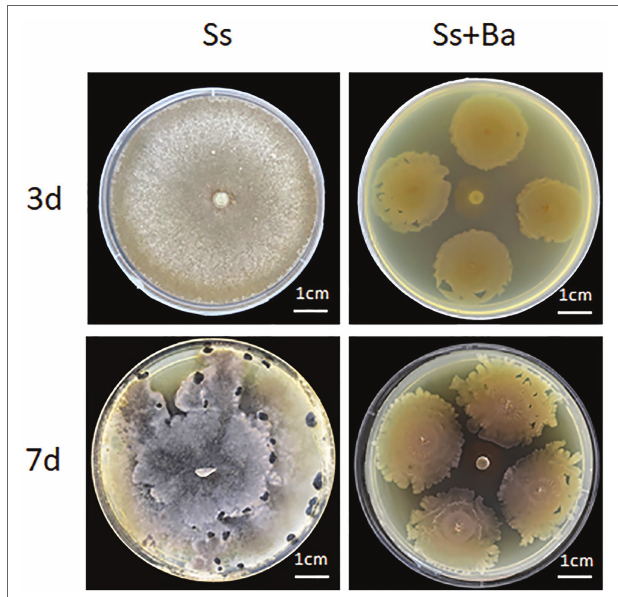
FIGURE 1 | The PDA plate confrontation experiment of Bacillus amyloliquefaciens antagonizing the growth of Sclerotinia sclerotiorum . Ba, B. amyloliquefaciens ; Ss, S. sclerotiorum .